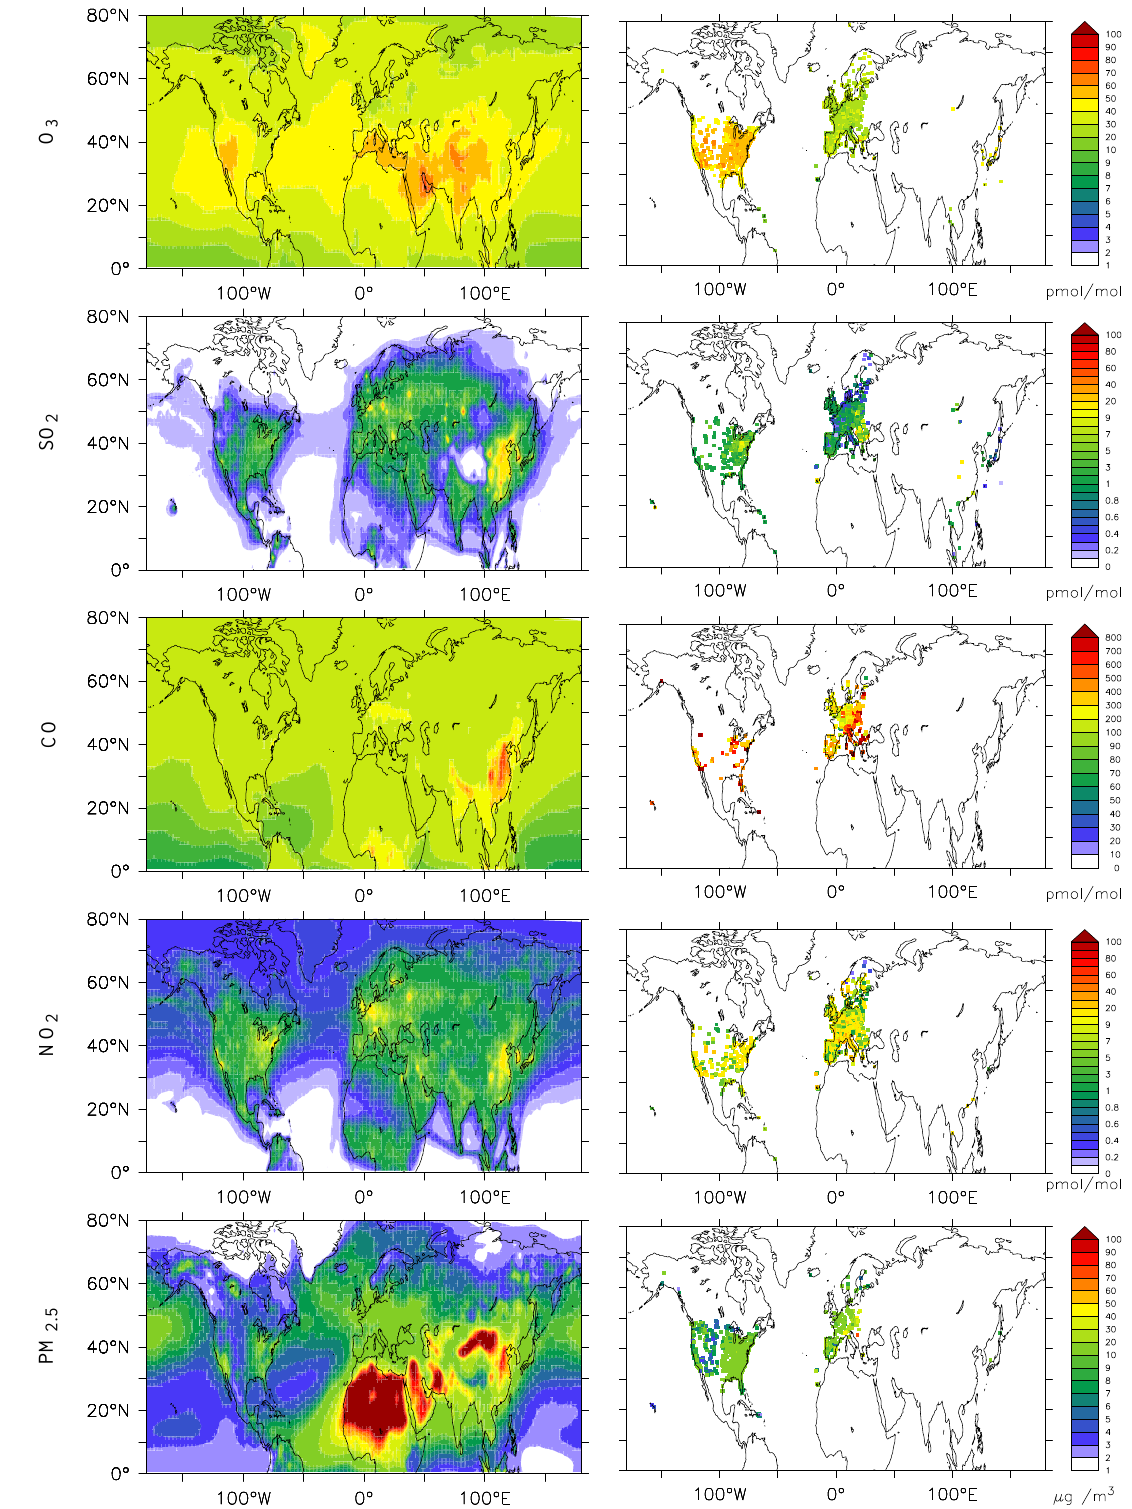
Fig. 1. LEFT PANELS: simulated annual mean mixing ratios (in pmol mnol − 1 and µg m − 3 for PM 2 . 5 ) for the year 2005. RIGHT PANELS: annual mean (in pmol mnol − 1 and µg m − 3 for PM 2 . 5 ) from the EPA, EEA and EANET network observations for the year 2005. The trace gases (from top to bottom) are O 3 , SO 2 , CO, NO 2 and PM 2 . 5